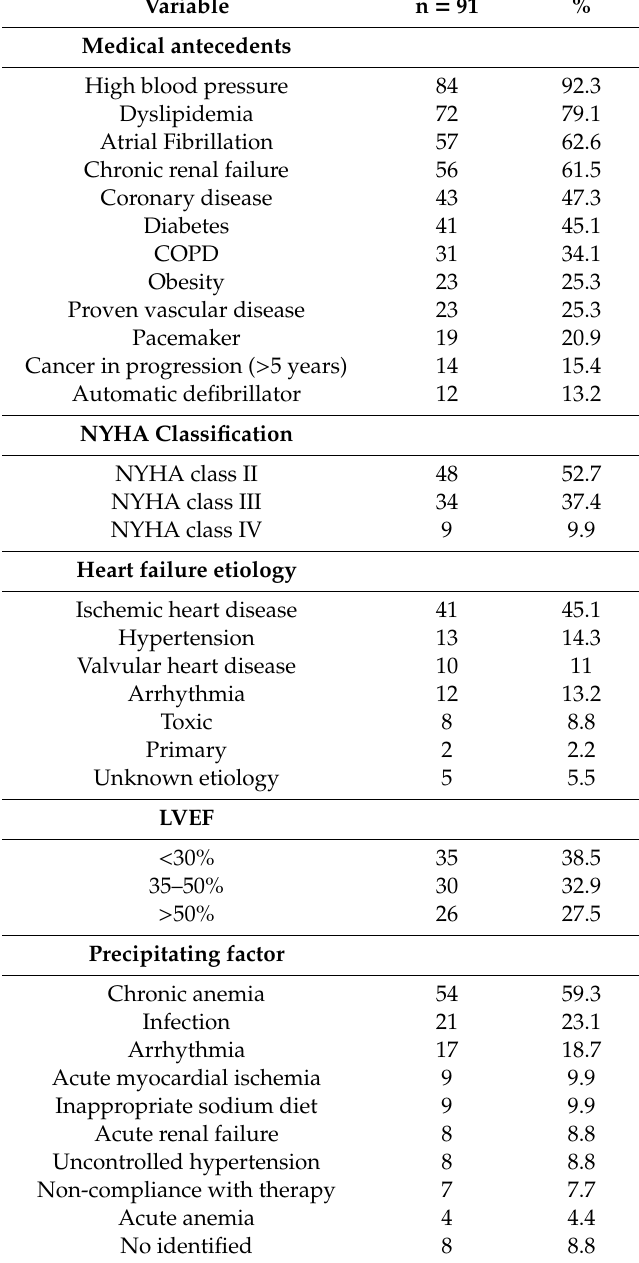
Table 1. General characteristics of the population